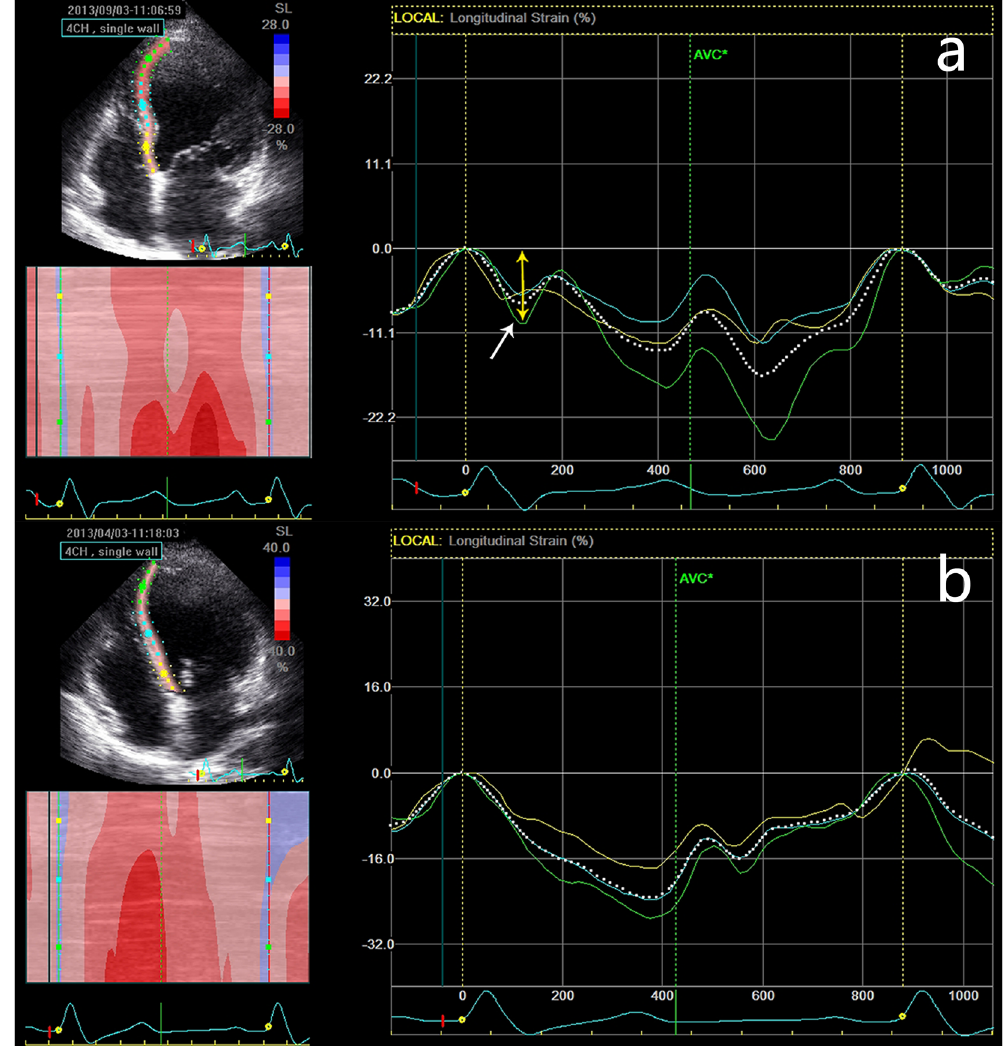
Figure 2. SF by 2D STE. Note the septal strain curve of LBBB-SF ( a ) and LBBB-NSF ( b ) patients. SF was defined as the presence of early leftward and then rightward septal motion within the isovolumic contractile period (white arrow). The magnitude of SF was defined as the maximal early negative peak strain in the involved septal myocardial segments (yellow arrow). LBBB, left bundle branch block; SF, septal flash; 2D STE, two- dimensional speckle-tracking